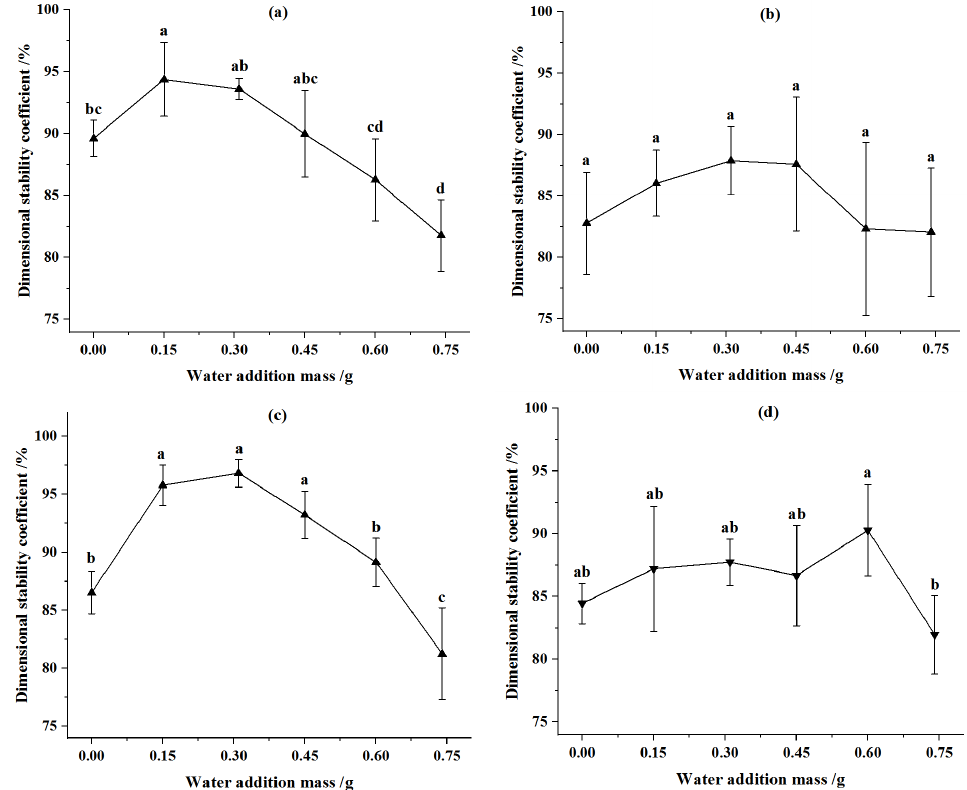
Figure 3. Effect of water addition on dimensional stability coefficient of pellets. ( a ) Particle size was 2 mm and compression displacement was 90 mm. ( b ) Particle size was 4 mm and compression displacement was 90 mm. ( c ) Particle size was 2 mm and compression displacement was 92 mm. ( d ) Particle size was 4 mm and compression displacement was 92 mm. Note: Different letters in the same line chart indicate a significant difference between the data ( p < 0.05).